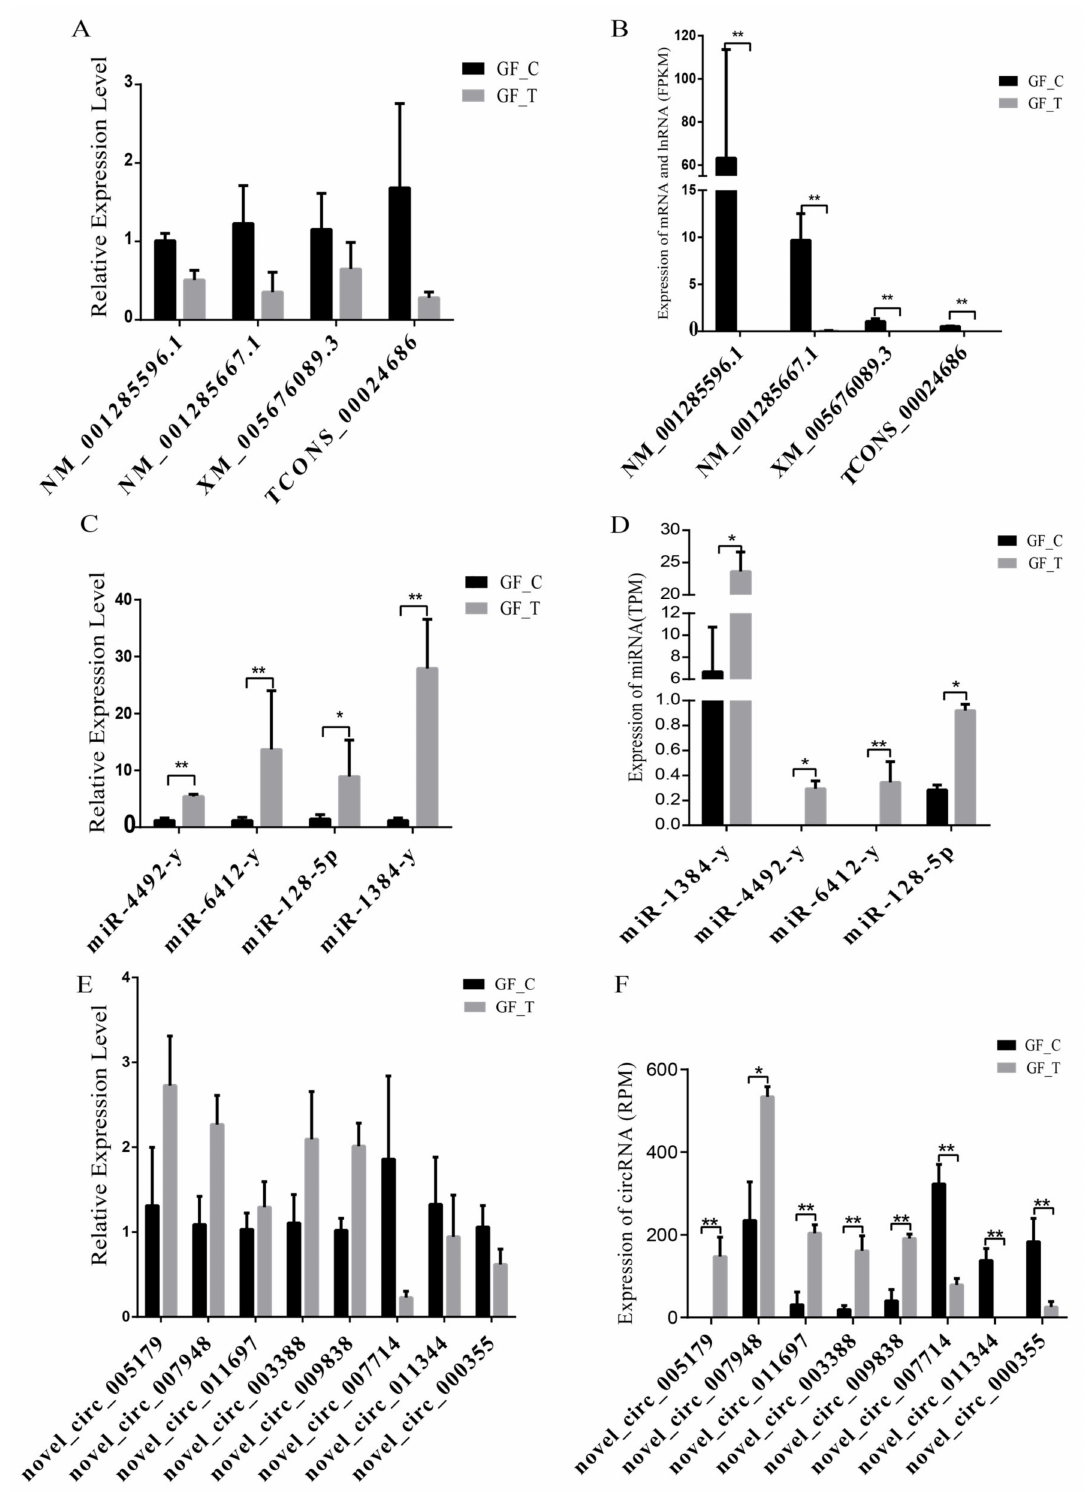
Figure 5. DEmRNAs, DElncRNAs, DEmiRNAs, and DEcircRNAs verified by RT-qPCR in LFs and SFs RNA-seq results: A, REL of mRNA and lncRNA by RT-qPCR; B, expression levels of mRNA and lncRNA (FPKM) by RNA-seq; C, REL of miRNA by RT-qPCR; D, expression levels of miRNA (TPM) by RNA-seq; E, REL of circRNA by RT-qPCR; and F, expression levels of circRNA (RPM) by RNA-seq; *: p < 0.05; **: p <